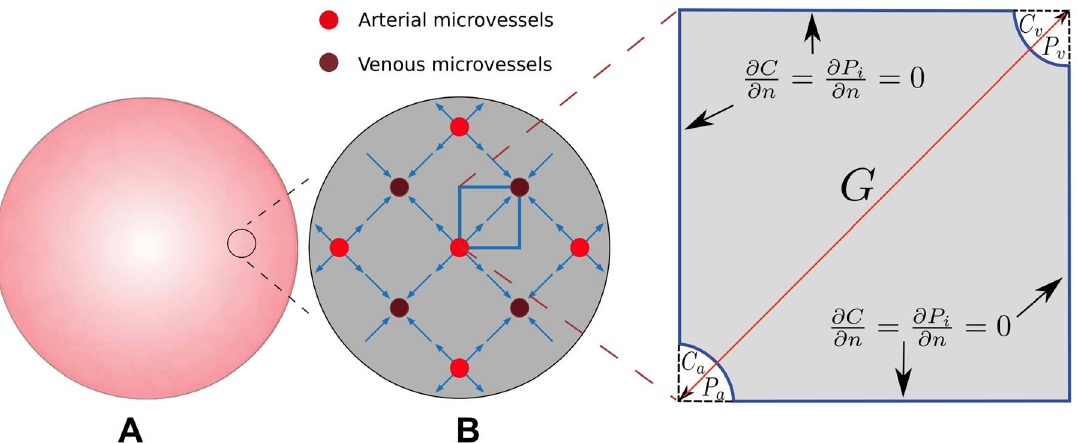
Figure 1. Illustration of a spherical tumor and schematic of the vascular distribution in a given tumor region. Illustration of a spherical tumor, and a darker region indicates a higher vascular density (subfigure A). A schematic of the vascular distribution in a given tumor region (subfigure B). The zoom-in region illustrates an equivalent block for simulating the transport of macromolecular carrier in tumor tissue. A smaller G value indicates a larger vascular density.